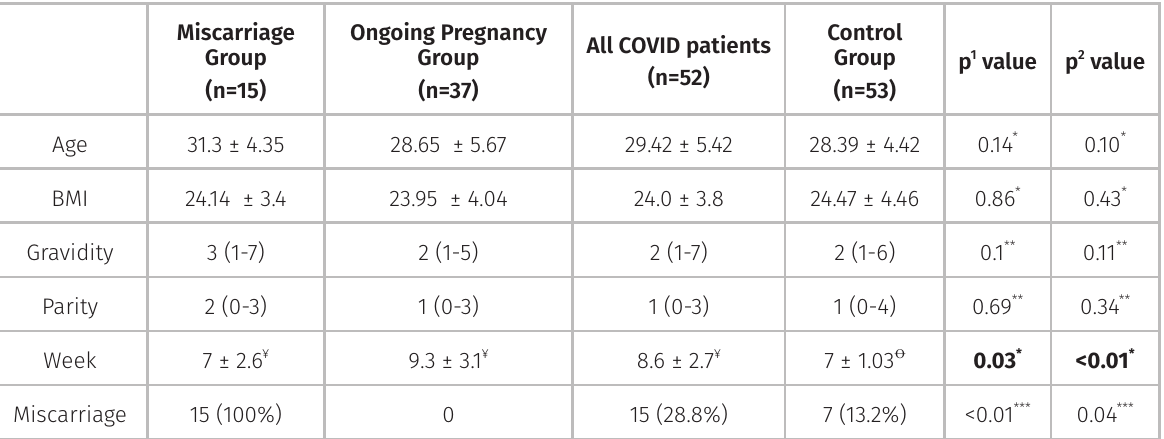
Table I. Demografic variables and